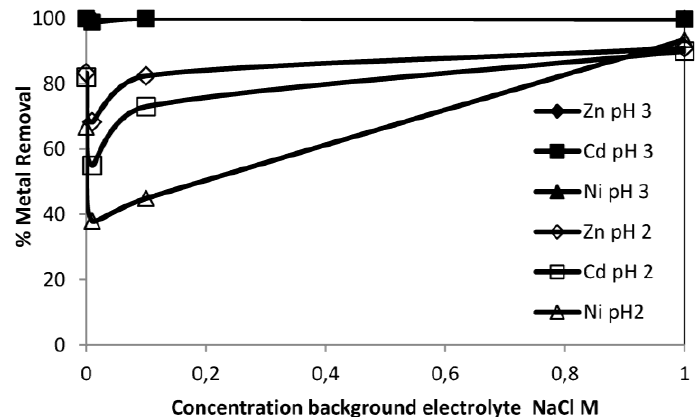
Figure 5. Effect of ionic strength on the removal of Zn, Cd and Ni.